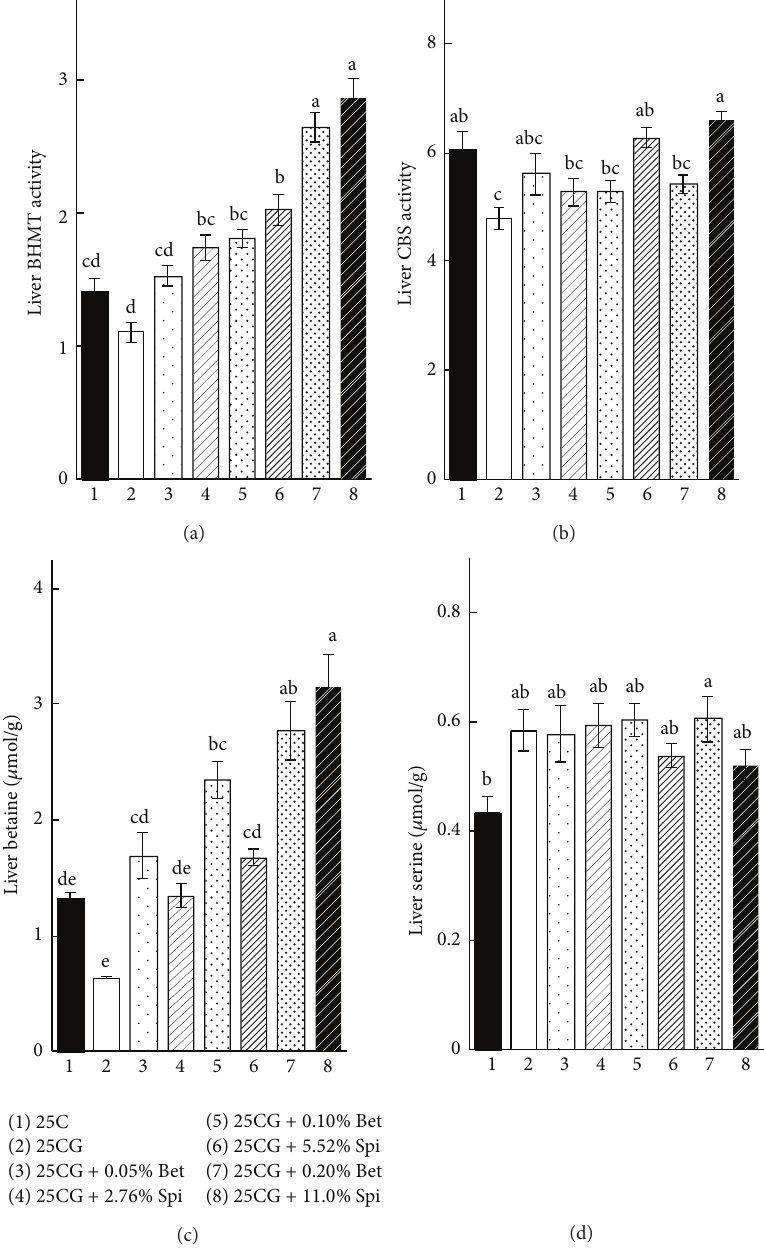
Figure 4: Activities of betaine-homocysteine S-methyltransferase (a) and cystathionine 𝛽 -synthase (b) and concentrations of betaine (c) and serine (d) in the liver of rats fed the experimental diets (experiment 1). Each value is the mean ± SEM, 𝑛 = 8 . Values in a panel without a common letter differ at 𝑃 < 0.05 . Enzyme activities are expressed in nmol/(min ⋅ mg